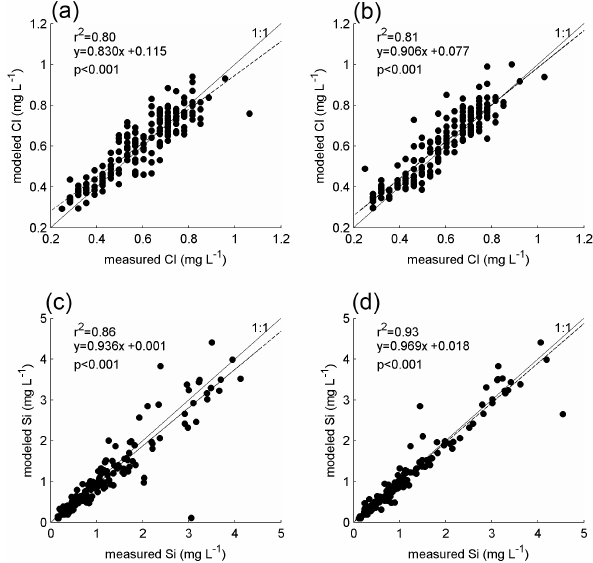
Figure 2. Comparison of modeled and measured Cl and Si concen- trations for BA-1 (a and c) and BA-2 (b and d)